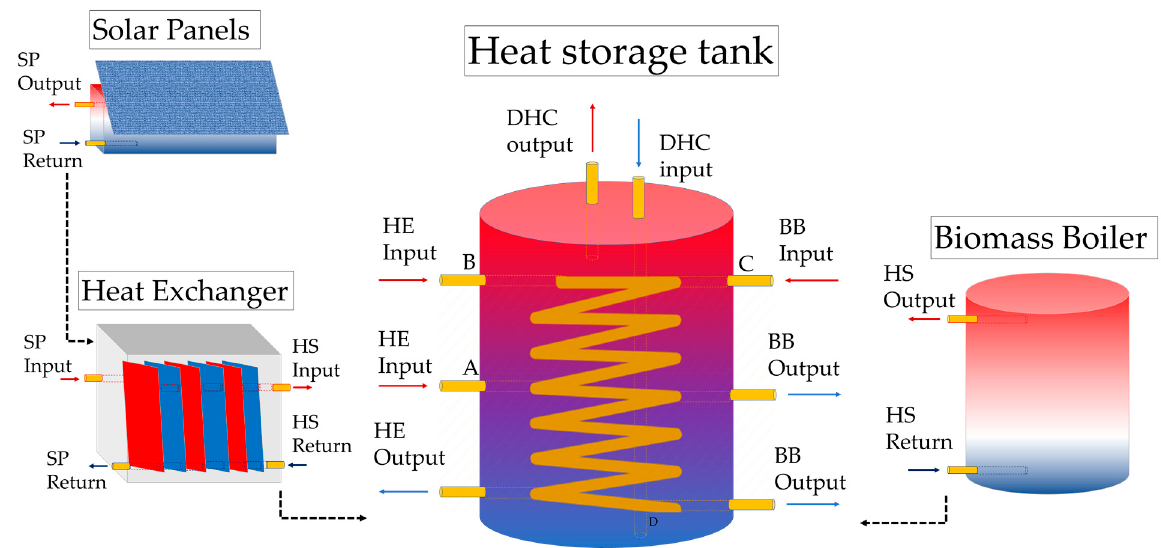
Figure 2. Schematic of the physical connection between the solar panels (SP), heat exchanger (HE), biomass boiler (BB) and the heat storage tank (HS).